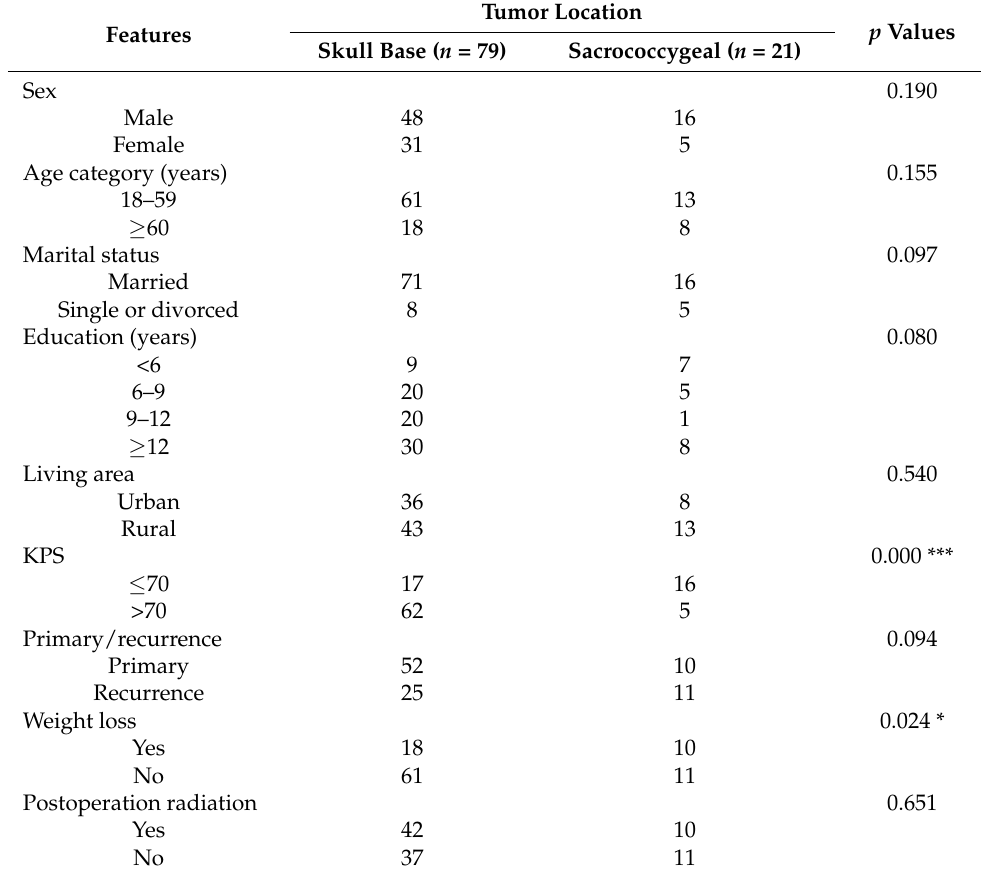
Table 1. Characteristics of 100 patients with